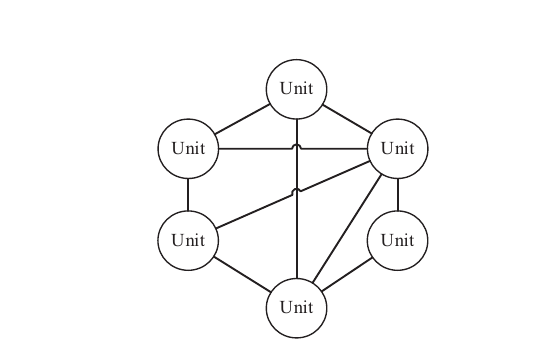
Figure 6. A network between units and advisers and